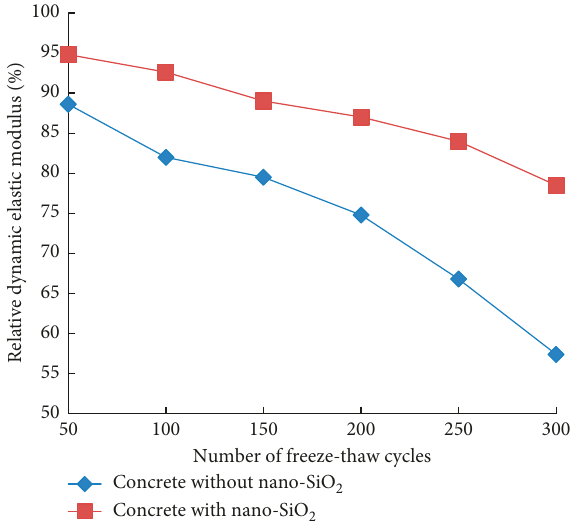
Figure 7: Change of relative dynamic elastic modulus with number of freeze-thaw cycles in chloride salt environment.